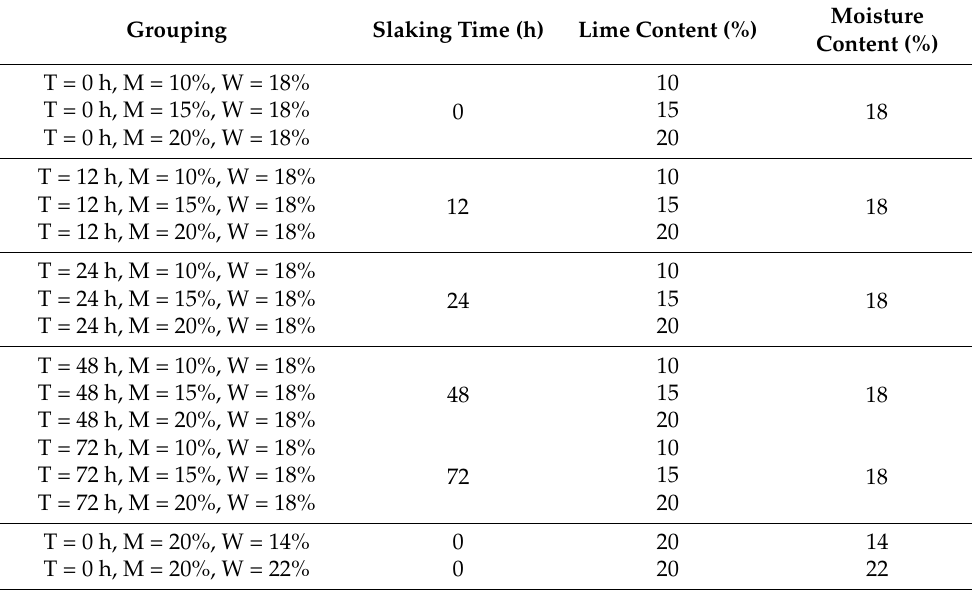
Table 3. Experimental factors of lime